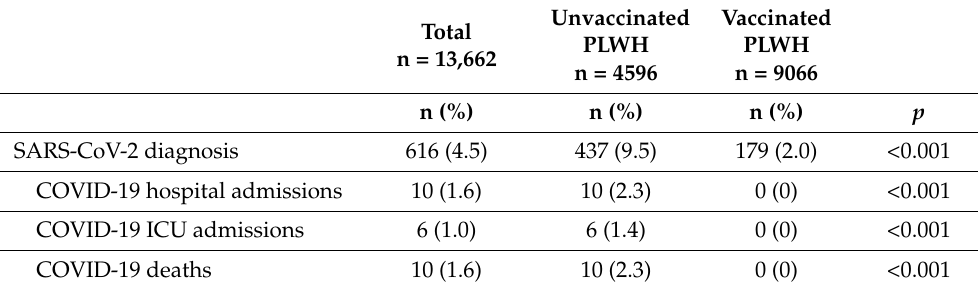
Table 3. SARS-CoV-2 diagnosis and associated clinical outcomes among people living with